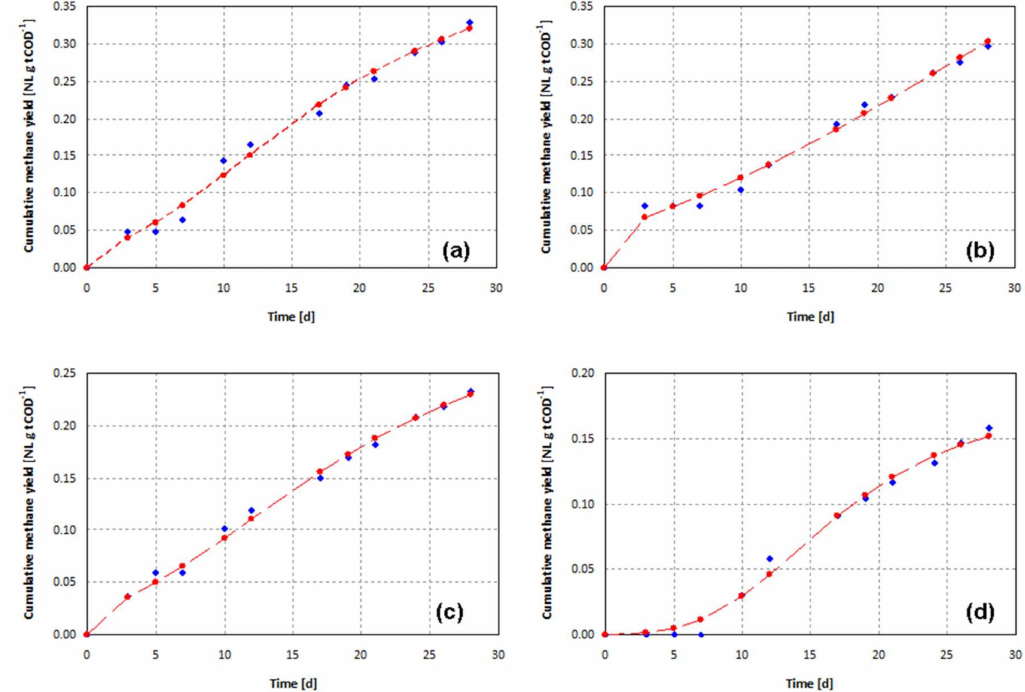
Figure 4. Measured and modeled (using the modified Gompertz Equation (5)) cumulative methane production of ( a ) c1, ( b ) T n-25-0 , ( c ) C 8-25-0 , and ( d ) C 10-25-0 . The capital letters of the tests indicate